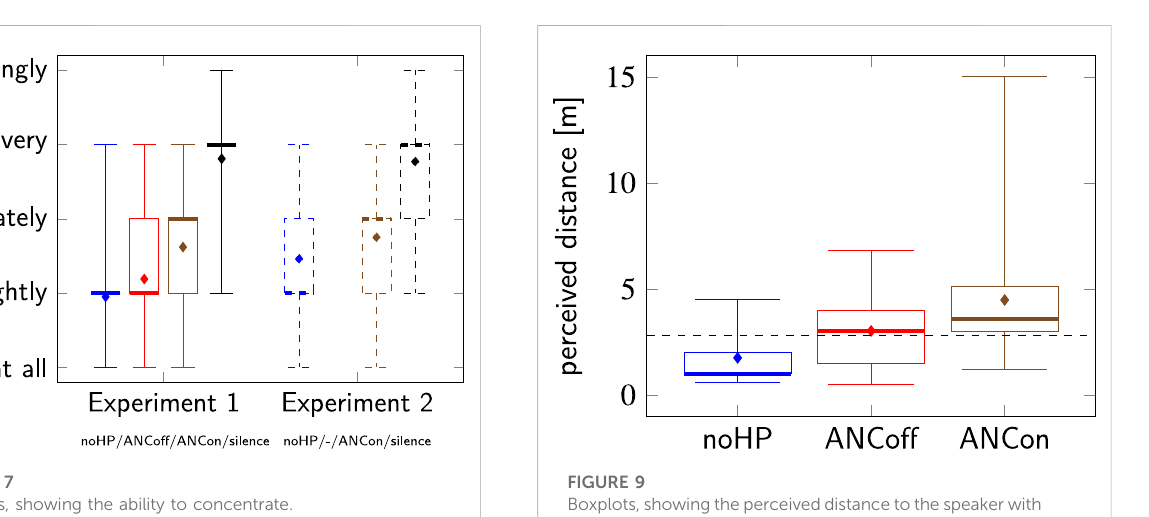
FIGURE 7 Boxplots, showing the ability to concentrate.